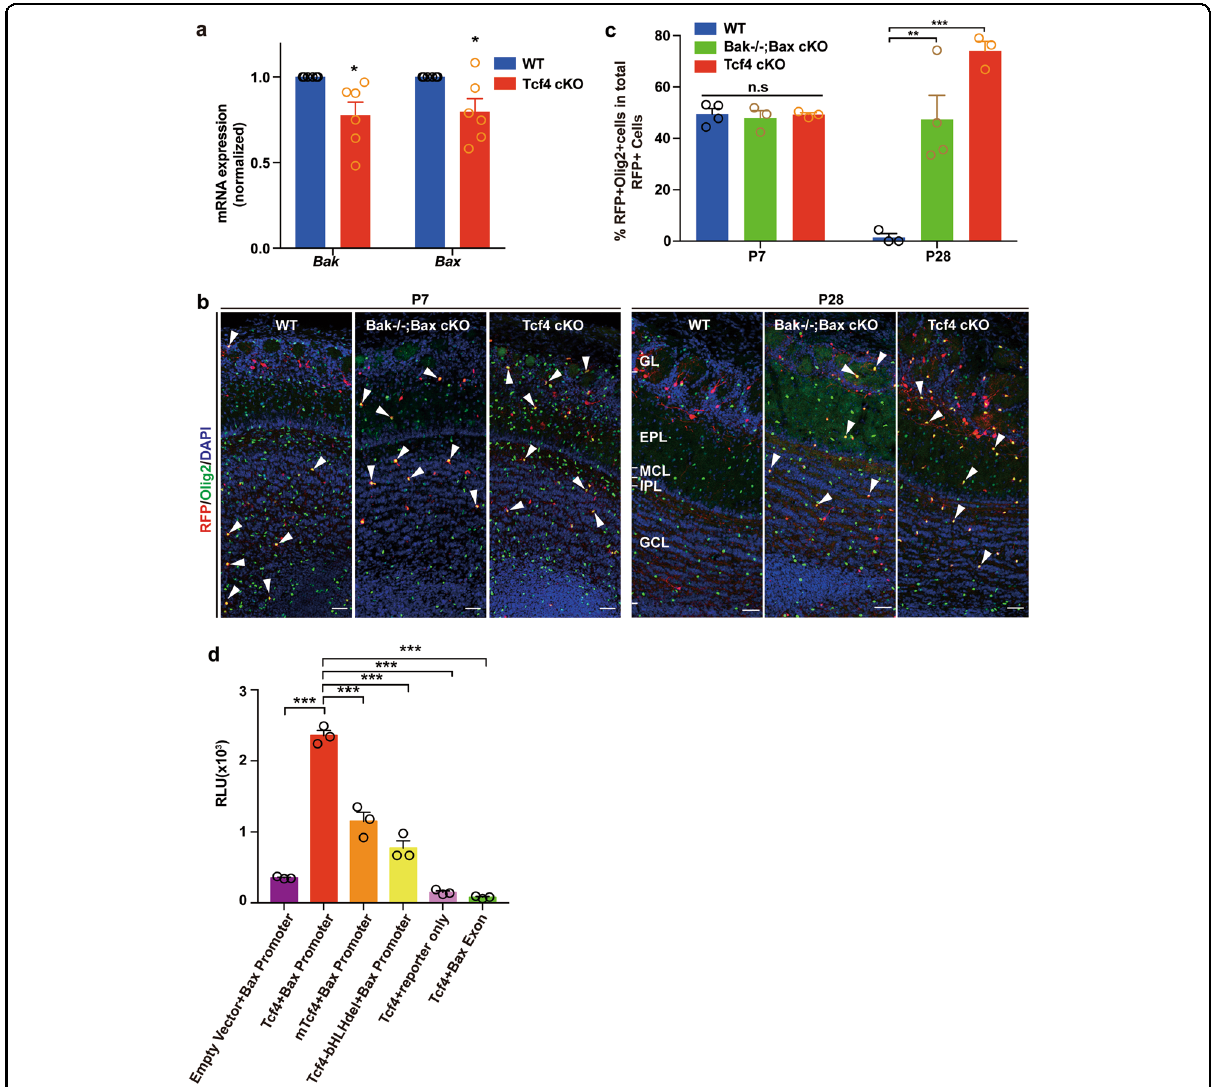
Fig. 7 Tcf4 regulates OPC survival through Bax/Bak pathway. a Relative expression level of Bax and Bak in WT and Tcf4 cKO OBs. The expression level of WT was normalized to 1. Student ’ s t test was used to compare two groups. Data are presented as mean ± SEM. * p < 005. Six OBs were analyzed for each genotype. b Representative images show immunostaining for Olig2 and RFP at P7 and P28 in OBs of WT, Bak1 − / − ;Bax cKO and Tcf4 cKO. Arrowheads indicate OPCs. Scale bar: 50 μ m. c Quanti fi cation of the number of OPCs from ( b ). Two-way ANOVA was used for statistical analysis. Data are presented as mean ± SEM. ** p < 0.01, *** p < 0.001, n.s. nonsigni fi cant. At least three OBs were analyzed for each genotype at each time point. d Tcf4 regulates Bax transcription examined by dual-luciferase assay. Tcf4 with disease-related point-mutations (mTcf4) and Tcf4 lacking the bHLH domain (Tcf4-bHLHdel) were used for examining the function of Tcf4 bHLH domain. Data are shown as mean ± SEM. One-way ANOVA, *** p <